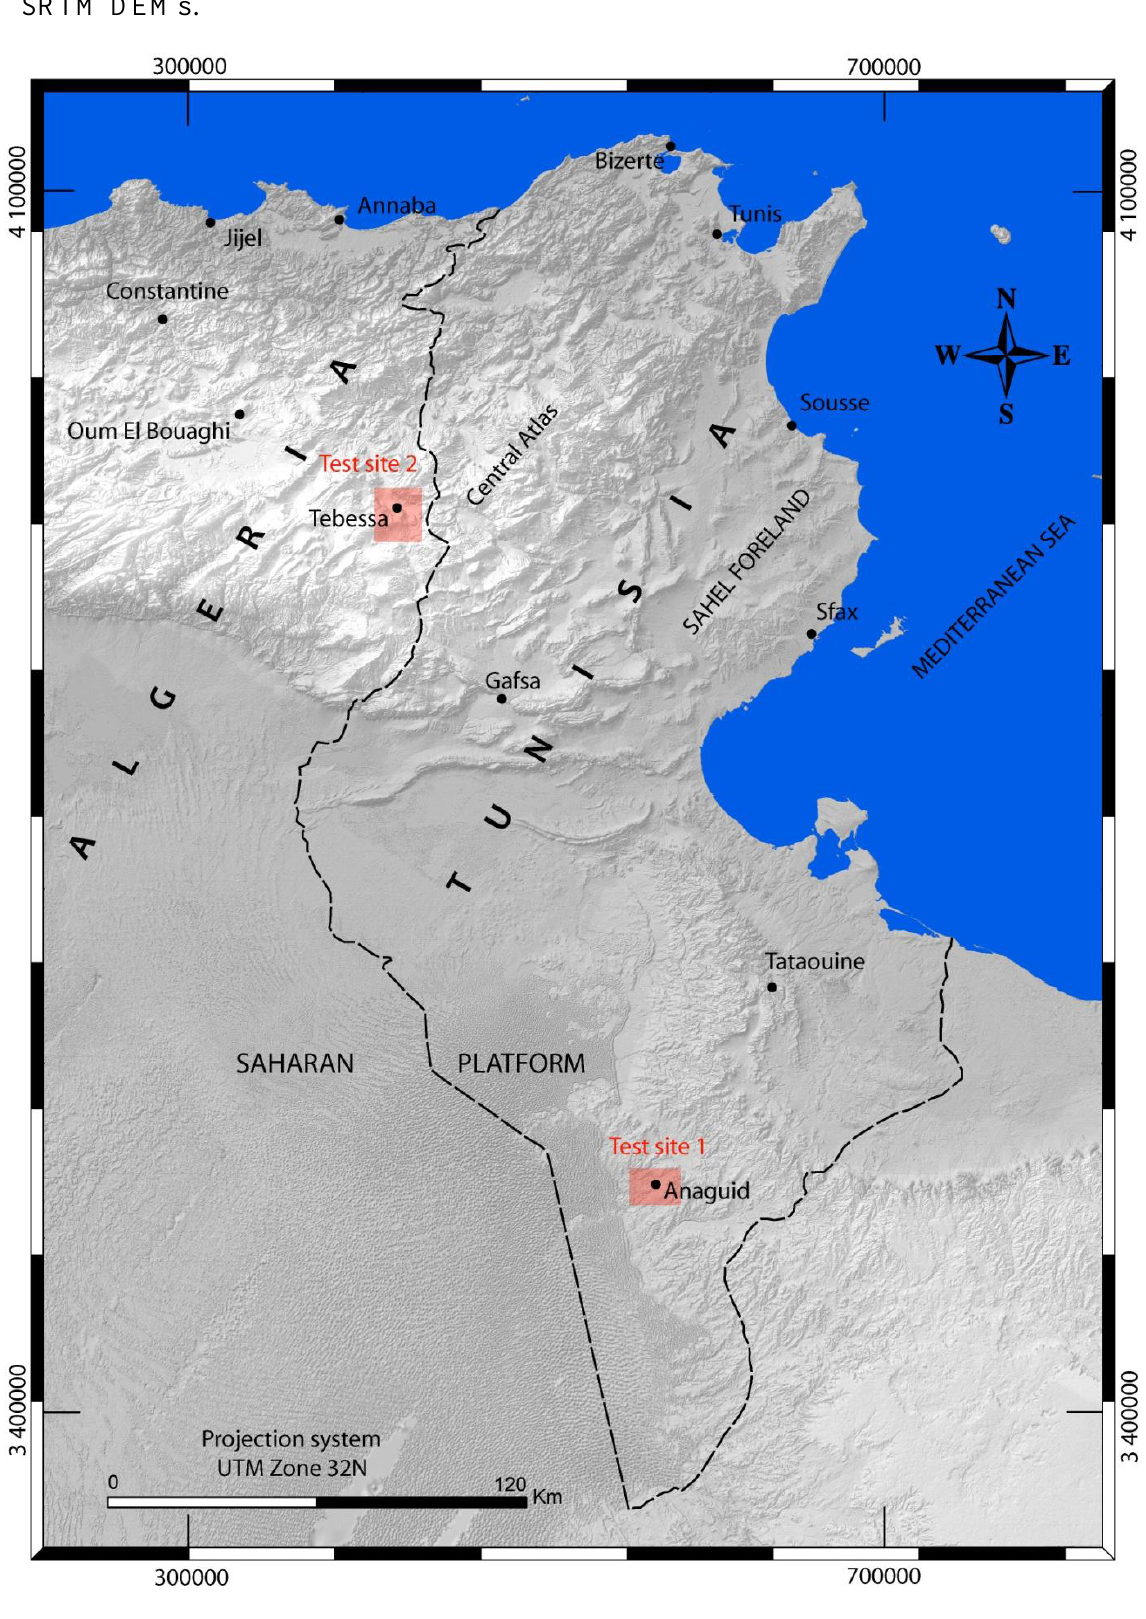
Figure 1. Location of the test sites plotted on a shaded relief map obtained from SRTM